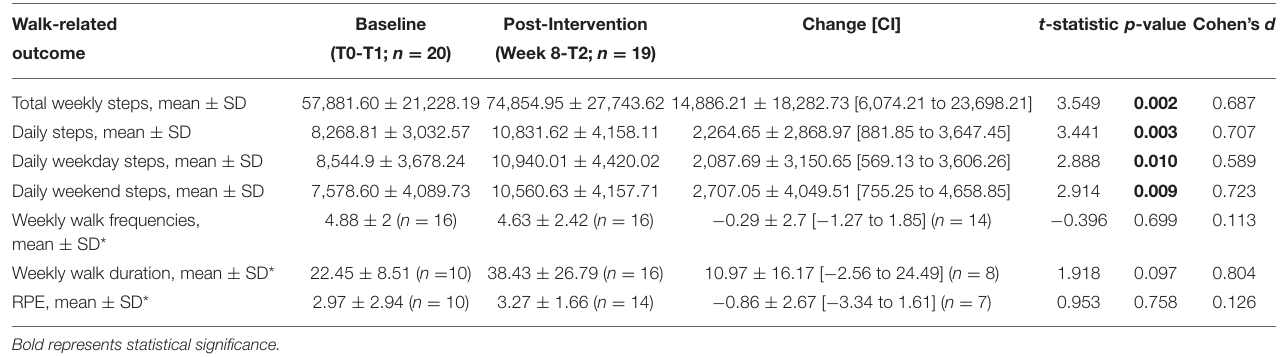
TABLE 4 | Descriptive statistics, paired sample t -test and effect size of steps walked, walk frequencies and duration, and perceived effort of the telehealth progressive walking intervention ( n = 20). Walk-related